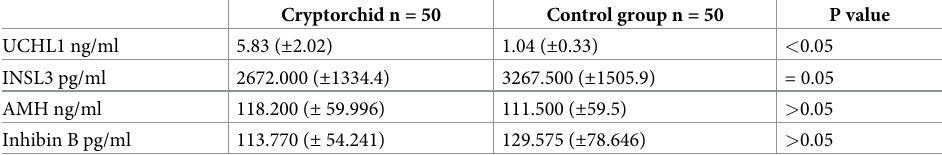
Table 1. The statistic parameters of UCH-L1, INSL3, AMH and inhibin B concentrations in plasma of children diagnosed with hernia and